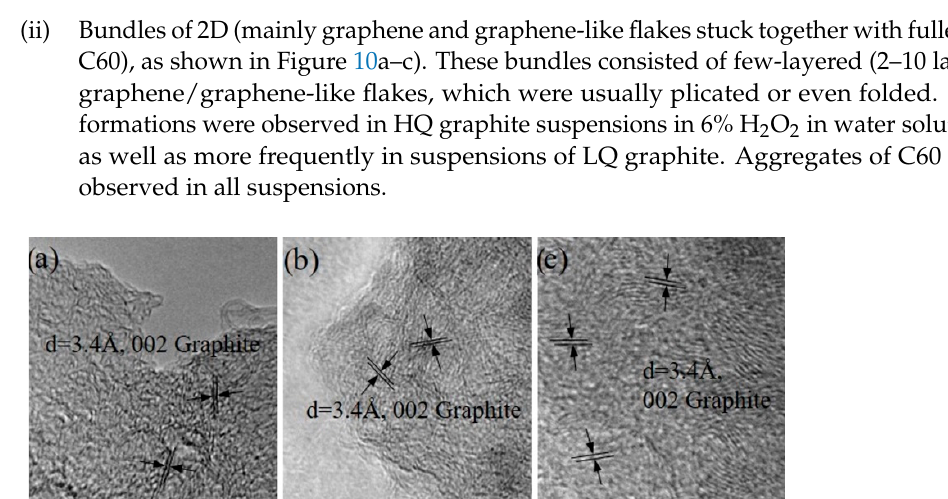
Figure 9. TEM image from an LQ graphite suspension in H 2 O before ( a ) and after ( b ) treatment with λ = 266 nm irradiation. Inset: Selected Area Electron Diffraction (SAED) patterns taken from the central area of the TEM image. The scale bar corresponds to 10 1/nm.